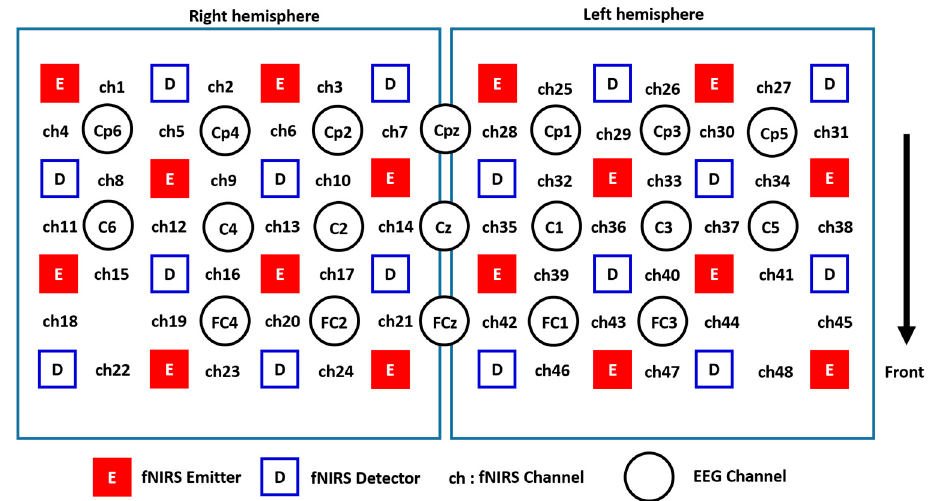
Figure 4. Distribution of the EEG electrodes and fNIRS optodes placed on both hemispheres of the motor cortex area.